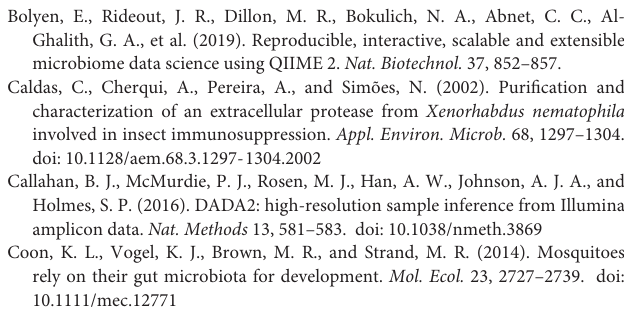
Supplementary Figure 1 | Growth kinetics of S. marcescens VA at 30 ◦ C in LB. The average ± SEM of three independent replicates is shown. Supplementary Figure 2 | Chao1 index in mosquitoes contaminated with S. marcescens VA. Data were generated from the same experiments as those to produce Figure 2B , and show the average ± SEM of three independent replicates. Supplementary Figure 3 | Quantification of hemolysis activity of S. marcescens VA in liquid. E. coli and sterile LB (-) were used as a negative control and SDS as a positive control. Data show the average ± SEM of three independent replicates. Supplementary Figure 4 | Peaks detected by HPLC at 208 nm are not found at other wavelengths. HPLC profile of S. marcescens crude extracts at 254 nm (A) and 280 nm (B) . C1-frc3 shows data from the methanolic fraction, which has been analyzed via NMR. A. U., arbitrary units. Supplementary Figure 5 | Effect of a low-dose oral infection of S. marcescens VA on Ae. aegypti . Adult females were fed with a sugar solution contaminated with bacterial strains at OD 600 nm = 1. (A) Survival analysis. ns, non-significant; ∗∗∗ p < 0.001. (B) Number of eggs laid per female and proportion of eggs hatching to larvae after contamination of the mother. (C) Proportion of males and females in the progeny at the adult stage. Data show the average ± CI (A) and ± SEM (B,C) of three independent replicates. Supplementary Figure 6 | Larvicidal activity of a crude extract of S. marcescens VA. Lethal concentration of bacterial extracts killing 50% of the larvae (LC 50 ) in 48 h. Bacterial extracts were prepared after culturing bacteria at 30 or 37 ◦ C for 24 or 48 h. The larvicidal assay was performed on 100 third-to-fourth instar larvae per condition and per replicate. Data show the average of three independent replicates and error bars show SEM. Supplementary Figure 7 | Coloration of Hfq -complemented S. marcescens C3. Bacteria were grown overnight at 30 ◦ C on LB-agar + Kanamycin. Left : Hfq -complemented C3; Right : C3 electroporated with an empty